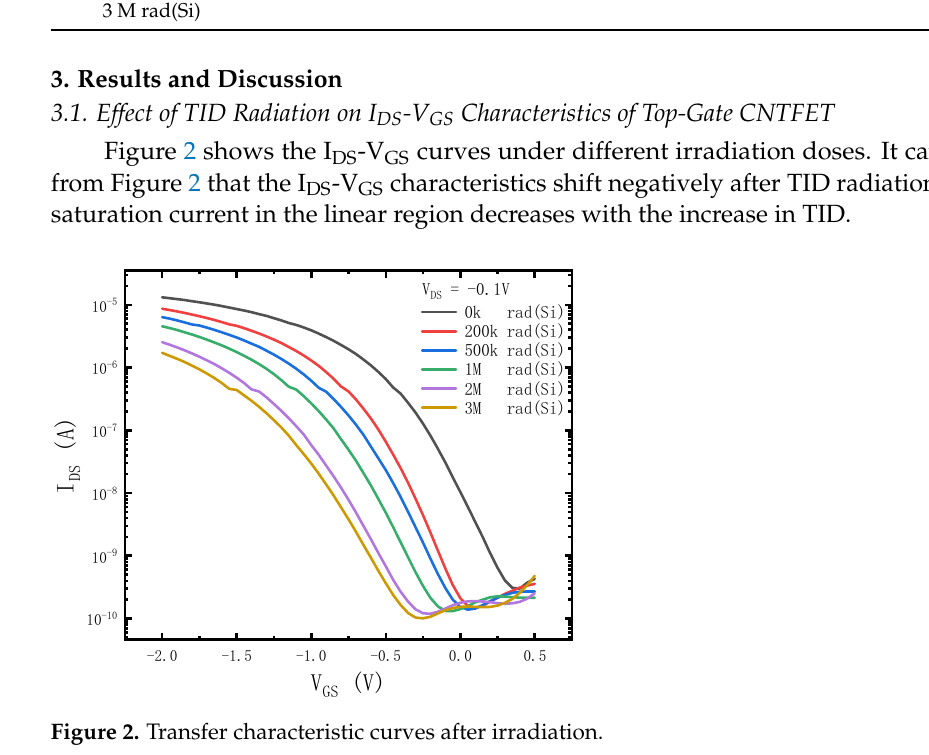
Table 1. Measurement information in this paper.